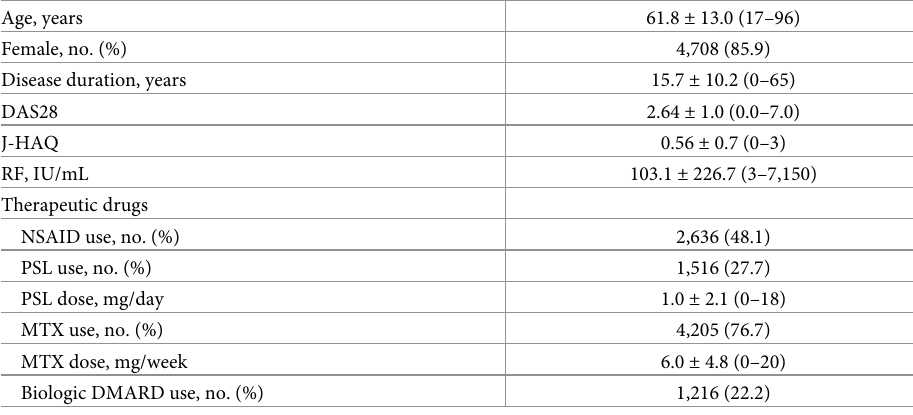
Table 1. Patient characteristics (n = 5,479). (cid:3) Age,